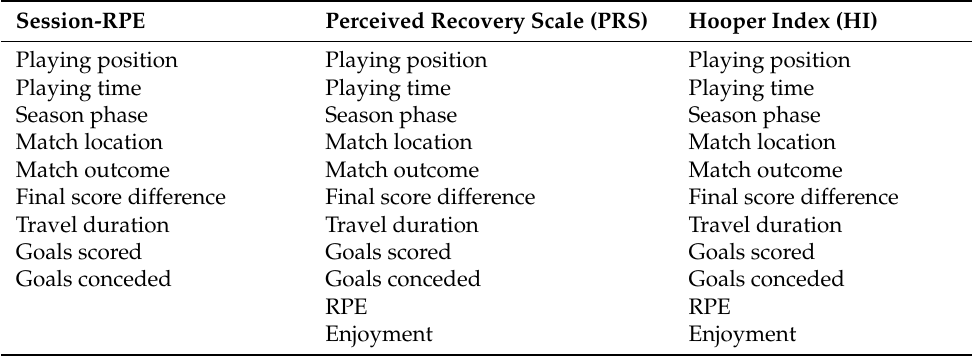
Table 1. Factors included in the main effect analysis.